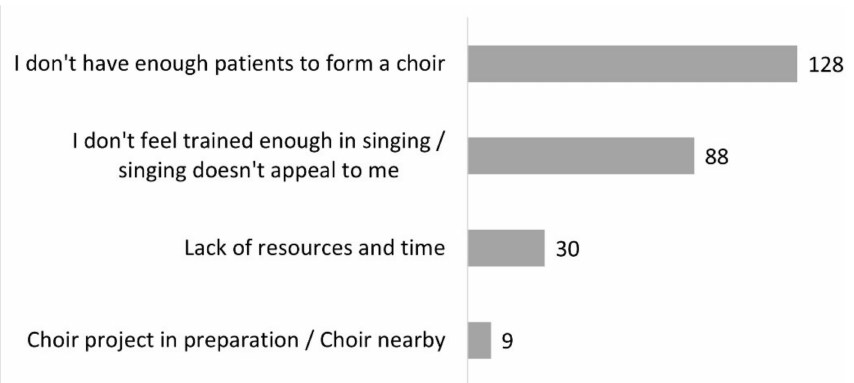
Figure 7. Reasons why participants did not start a choir (question #15 of the questionnaire, 218